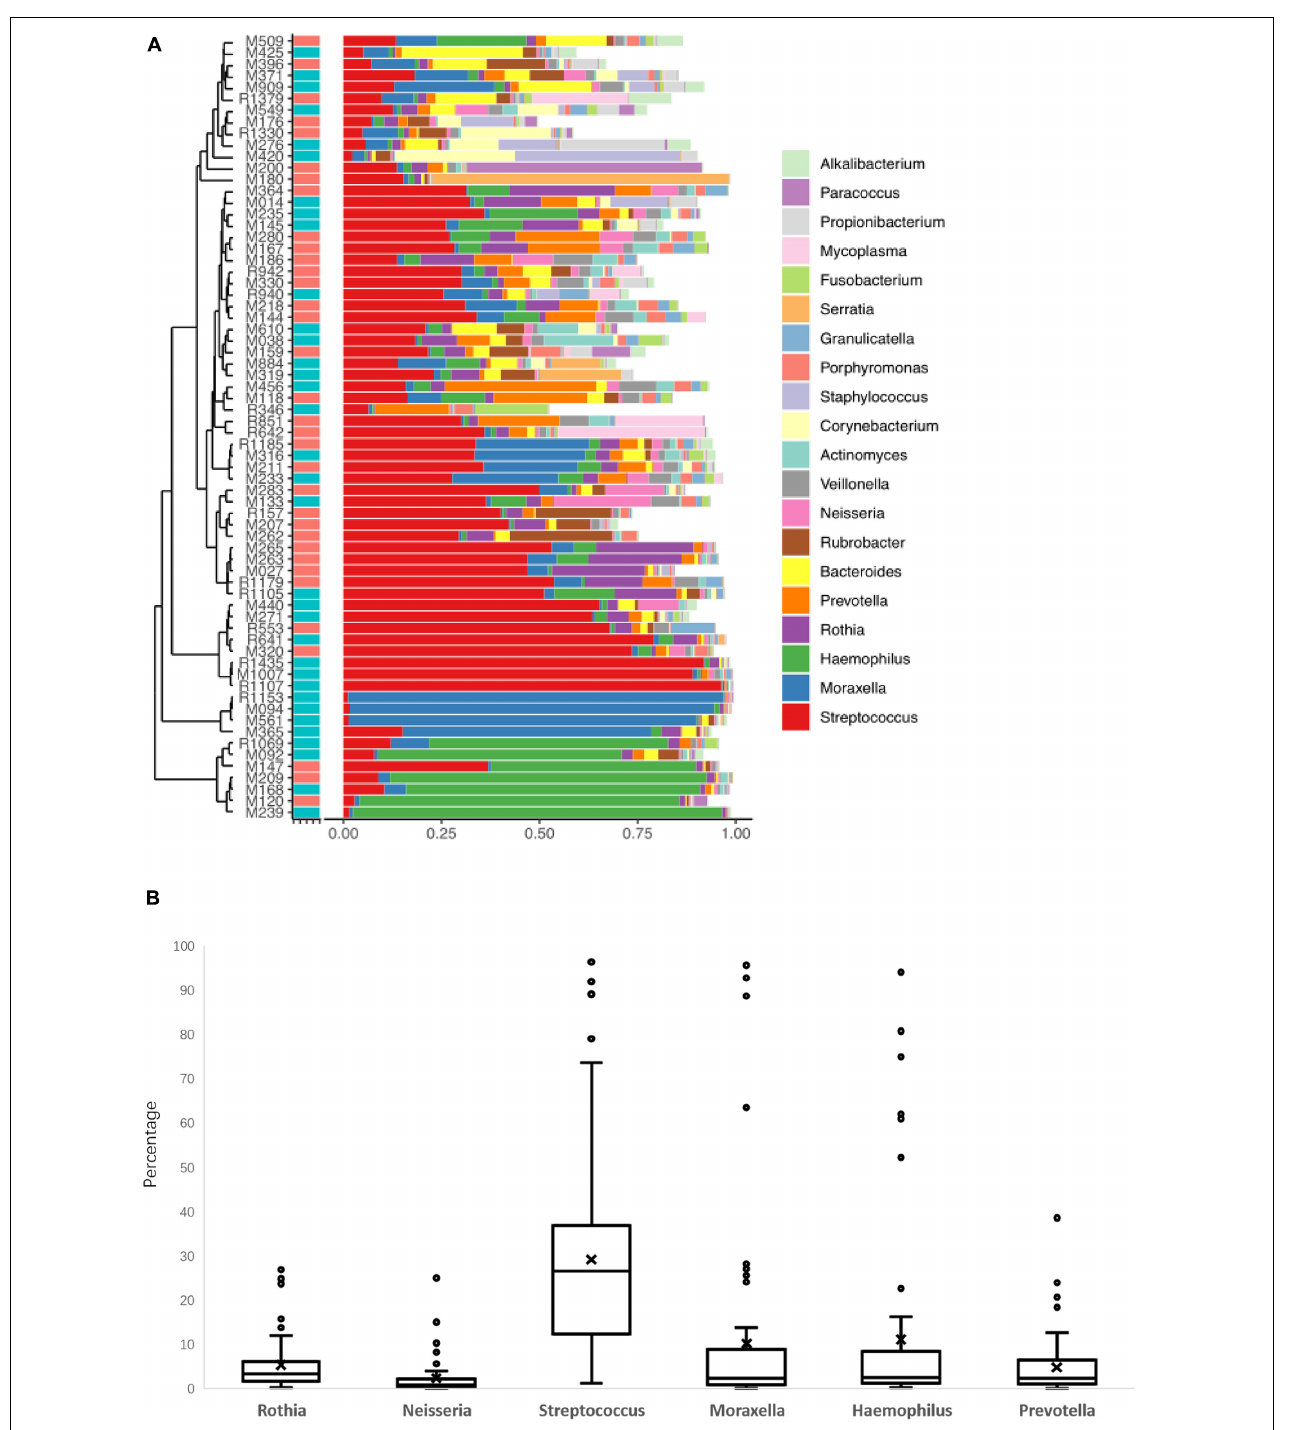
FIGURE 1 | The lower respiratory tract (LRT) microbiome composition profiles for the 68 patients in this study (A) . The percentage of the six genera of bacteria was found in all patients (B) .